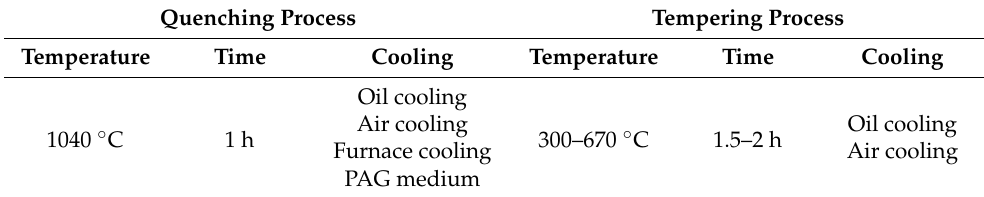
Table 2. Schedule of the heat treatment experiment of X6CrNiMoVNb11-2 stainless